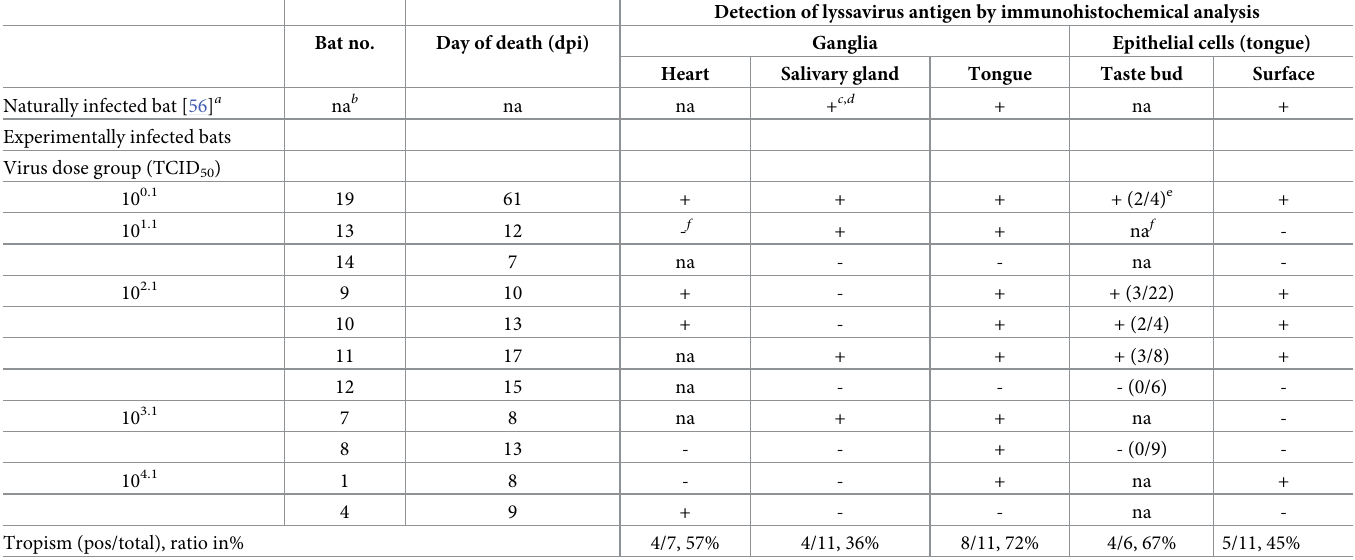
Table 4. Lyssavirus antigen expression in peripheral nerve ganglia and tongues of rabid bats, based on immunohistochemical analysis. No antigen was detected in the lung, kidney, liver, spleen, duodenum, jejunum or large intestine of any of these bats. Detection of lyssavirus antigen by immunohistochemical analysis Bat no. Day of death (dpi) Ganglia Epithelial cells (tongue) Heart Salivary gland Tongue Taste bud